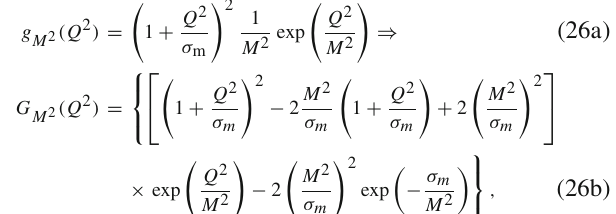
Table 2 The MS coefficients (cid:3) d n and d n (with κ = 1) ( n ≤ 10) for the three cases of d 4 Eq. (23) n d 4 = 275 . : (cid:3) d